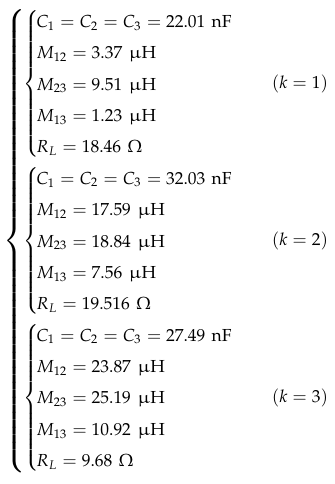
Center Frequency (kHz) Bandwidth (kHz) f o,1 = 150 b 1 = 10 f o,1 =